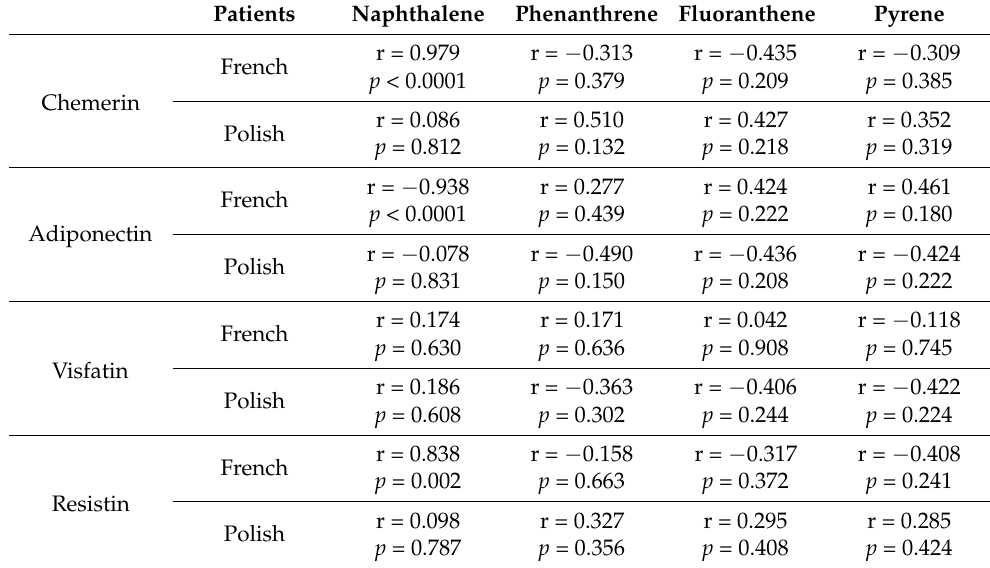
Table 5. Correlation between PAH concentration and adipokines level in blood plasma of French ( n = 10) and Polish ( n = 10)